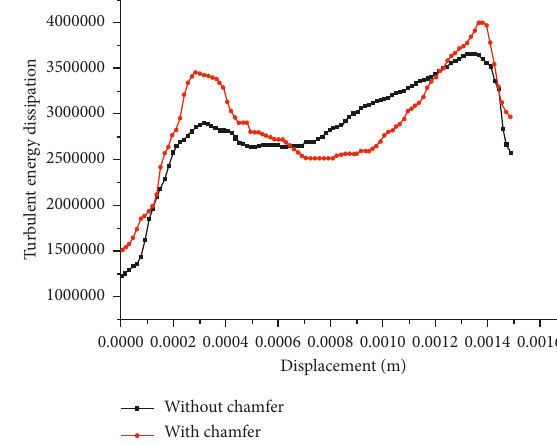
Figure 24: Distribution of turbulent kinetic energy at extension of cross